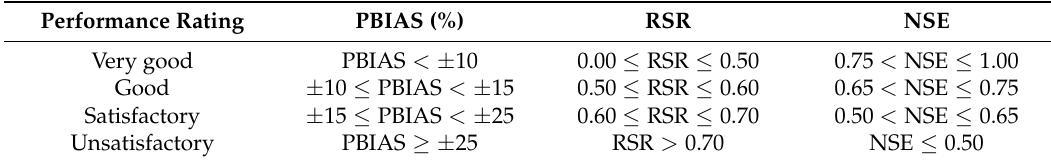
Table 4. General performance ratings for recommended statistics for monthly time step